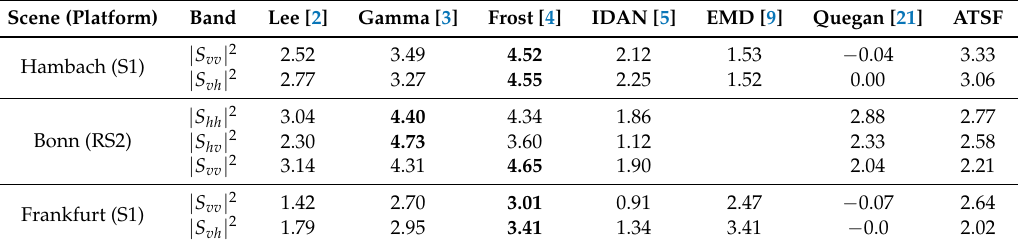
Table 1. Comparison of mean bias values, best results in boldface.